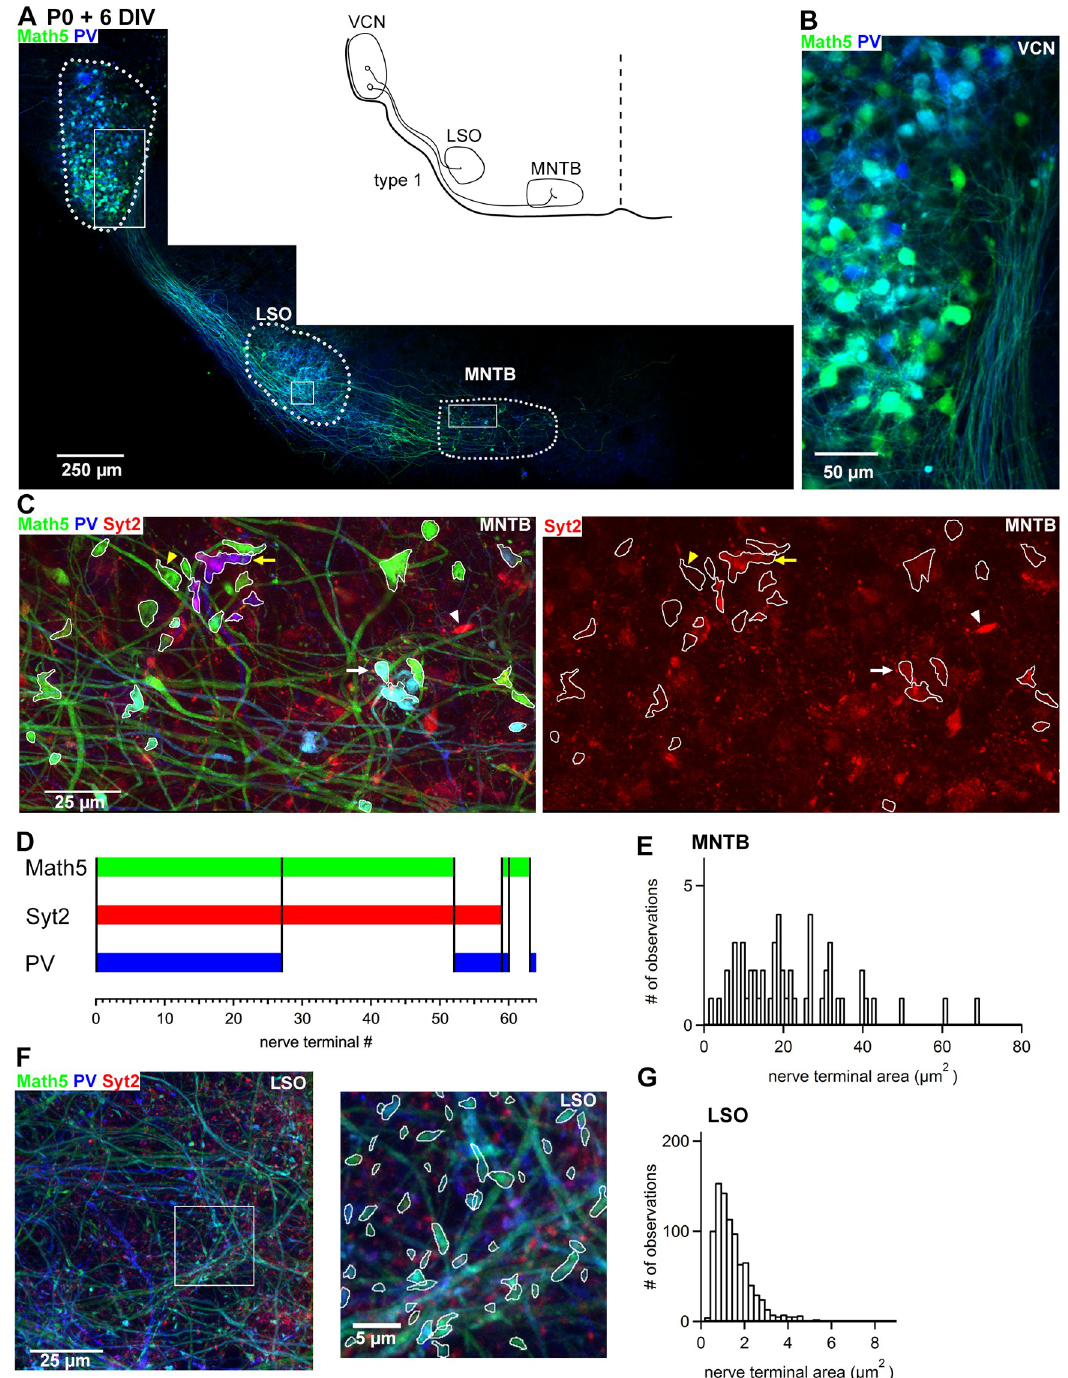
Fig 3. Math5- and Syt2-positive large nerve terminals are found in MNTB but not LSO neurons in organotypic slices. A , Overview image of a slice culture preparedfrom a Math5 Cre x Brainbow mouse at P0, using a slice angle of 15˚ duringpreparation of the coronal slices (see Fig 2). After 6 days in-vitro the slice culture was fixed and stained with an anti GFP-antibody (green channel),an anti-PV antibody (blue channel), and an anti-Syt2 antibody (red channel). B , VCN at a highermagnification. C , Maximal intensity projectionimage (stack of 60 images; z step 0.5 μ m) from within the MNTB area (boxedregionin A); the right image shows the anti-Syt2 immunohistochemistry (red channel)in isolation. Large calyx-like terminals, capturedon the level of their largest cross-section,are outlined in white. White arrow , exampleof a nerve terminalpositive for Math5, Syt2 and PV; white arrowhead ;nerve terminal positive for Syt2 alone; yellow arrow , nerve